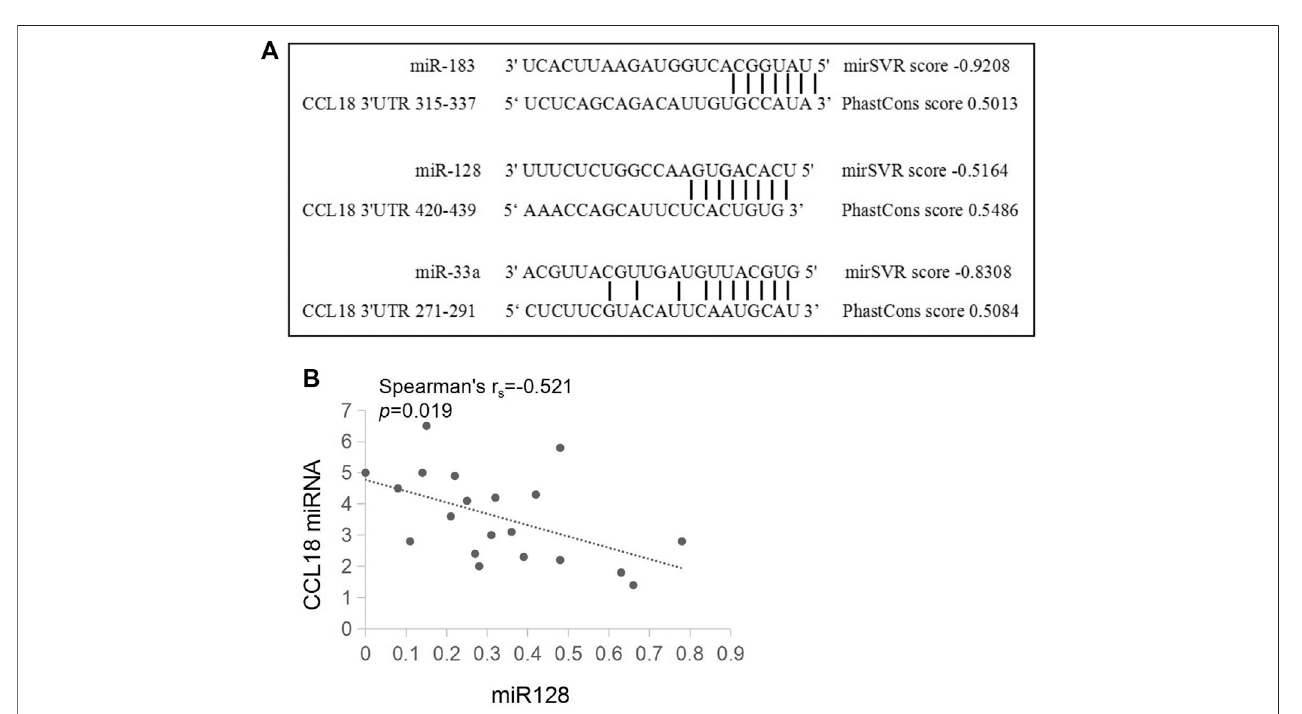
FIGURE 3 | There is a pairing relationship between ccl18 and the three types of miRNAs and a negative correlation with the amount of miR128 expressed. (A) is a schematic of CCL18-3 ′ UTR and miR-183, miR-128, and miR-33a sequence binding. (B) is the relationship between CCL18 and the relative expression amount of